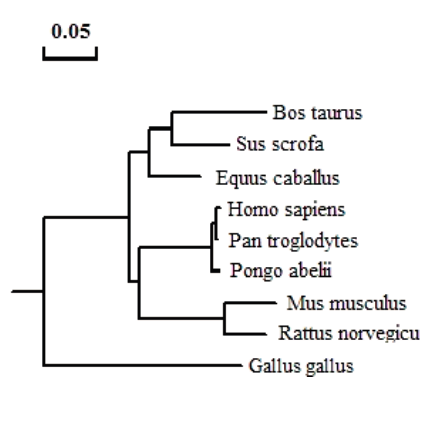
Figure 4. Phylogenetic analyses of the Stra8